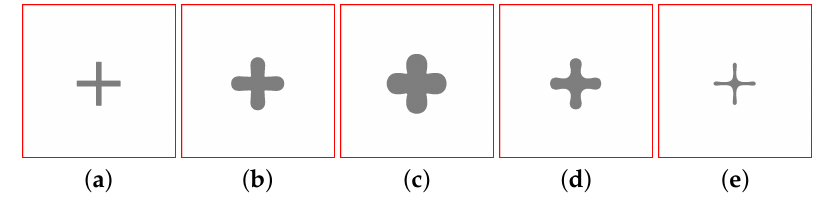
Figure 3. Model spatio-temporal evolution in a two-dimensional grid. ( a ) original pattern introduced as the initial condition by means of u ; ( b , c ) the model is left to freely evolve for a limited number of iterations; ( d , e ) a switch of the nullclines configuration reverses the wavefront’s direction of propagation, and the original pattern contracts over